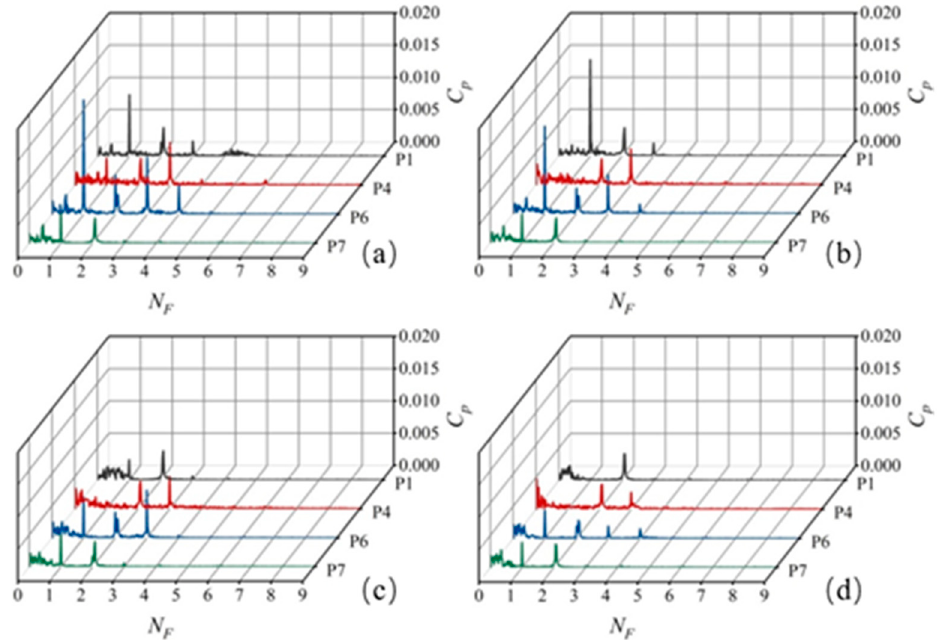
Figure 11. Frequency domains of pressure fluctuations under different NPSHa. ( a ) NPSHa = 5.51 m, ( b ) NPSHa = 4.28 m, ( c ) NPSHa = 3.05 m, ( d ) NPSHa = 1.82 m .